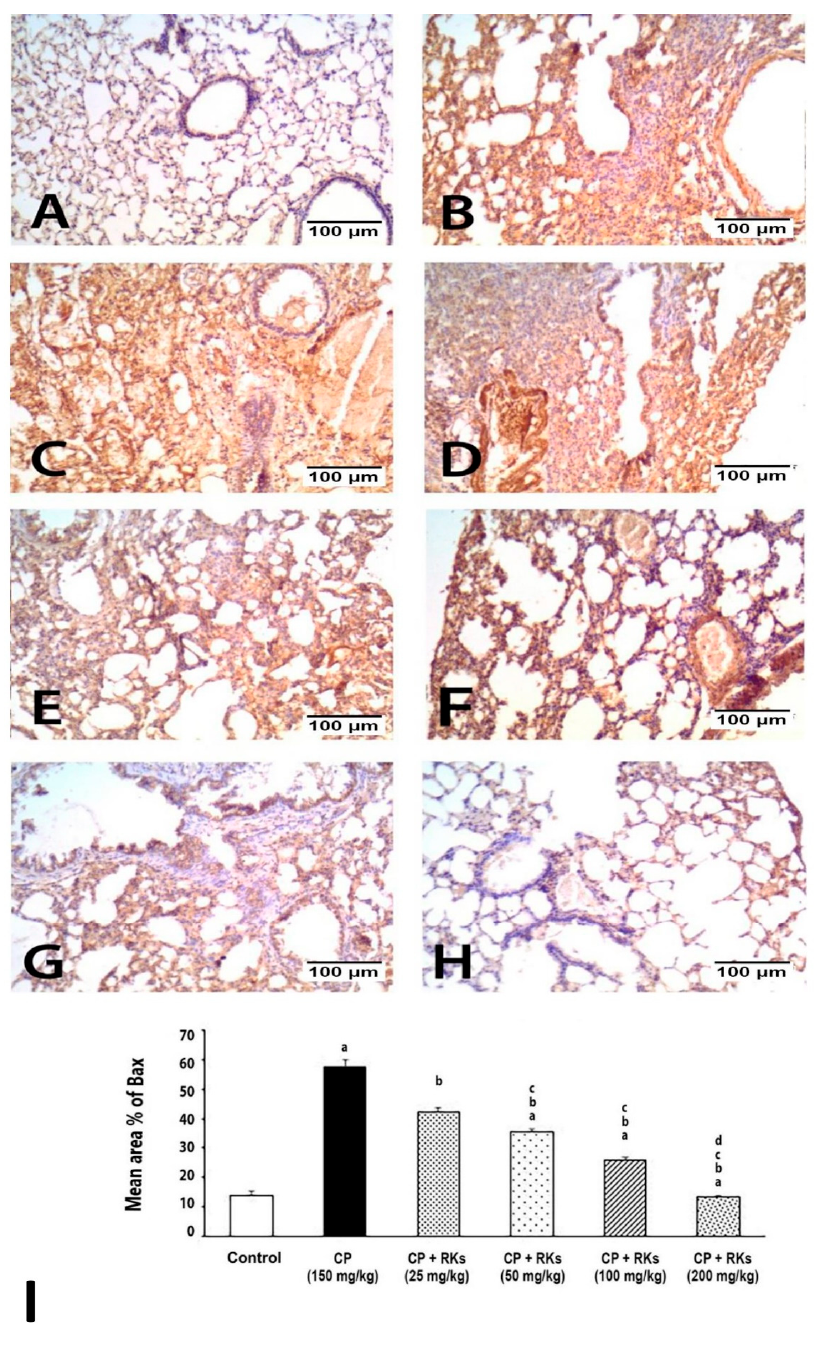
Figure 3. Photomicrographs showing Bax immunoexpression on the lung tissue of different experimental groups. ( A ) Negative to weakly immunoreactivity control group. ( B – D ) strong immunoreactivity of CP group. Immunoreactivity to Bax was decreased as the dose of RKs increased as shown in ( E ) RKs 25 mg/kg, ( F ) RKs 50 mg/kg, ( G ) RKs 100 mg/kg and ( H ) RKs 200 mg/kg. ( I ) graph of the mean area % of immunoreaction to Bax. Results are expressed as mean ± S.E. and analyzed using One Way ANOVA followed by Bonferroni’s post-hoc test at p ≤ 0.05 ( n = 4–6). a Indicates significant di ff erences from + control (Control) mice. b Indicates significant di ff erences from CP, c Indicates significant di ff erences from RKs (25 mg / kg / p.o), d Indicates significant di ff erent from RKs (50 mg / kg /